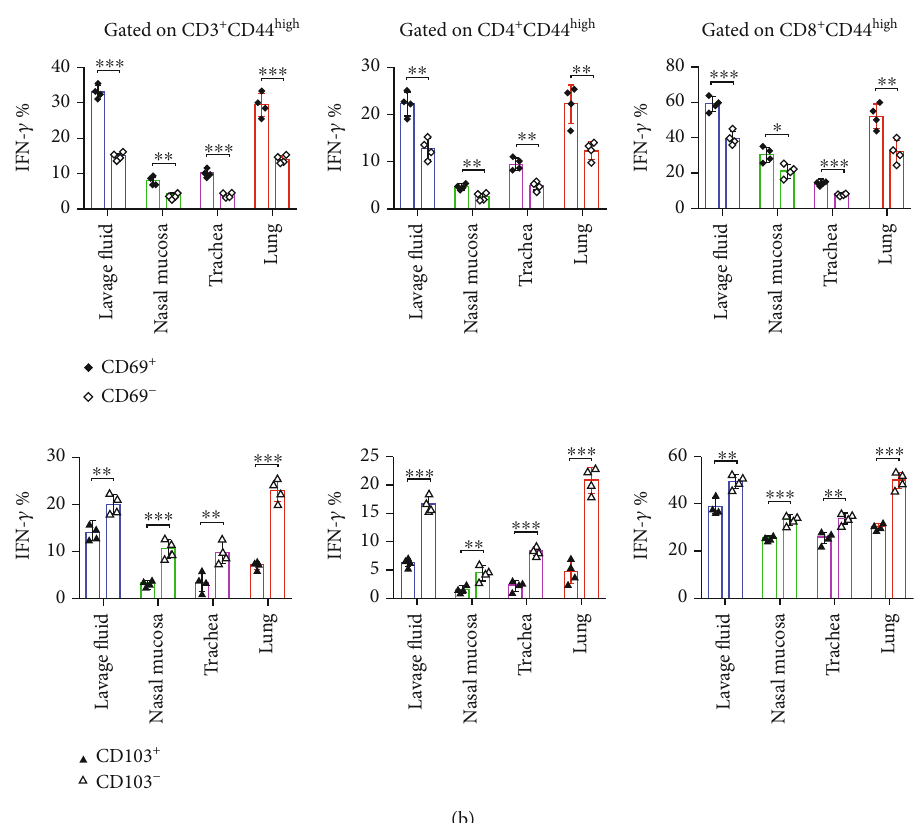
Figure 5: The expression of IFN- γ was higher in CD69 + and CD103 − T cells than CD69 − and CD103 + T cells when stimulated by PMA and ionomycin. (a) Live and singlet T cells from lavage fl uid, nasal, trachea, and lung tissues were gated on CD3 + CD44 high , CD4 + CD44 high , and RM CD8 + CD44 high T cells and subsequently analyzed on the expression of IFN- γ by fl ow cytometry. All cells were stimulated for 6 hrs with PMA and ionomycin in the presence of BFA in fl ow tubes. (b) The cells were detected for the frequency of INF- γ in CD69 − /+ or CD103 − /+ cells by FACS. Statistical signi fi cance was determined with two-way ANOVA. ∗ P < 0 : 05 , ∗∗ P < 0 : 01 , and ∗∗∗ P < 0 : 001